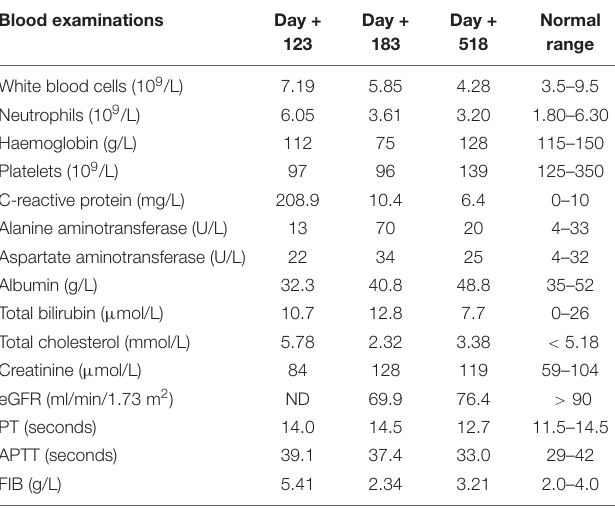
TABLE 1 | Results of blood